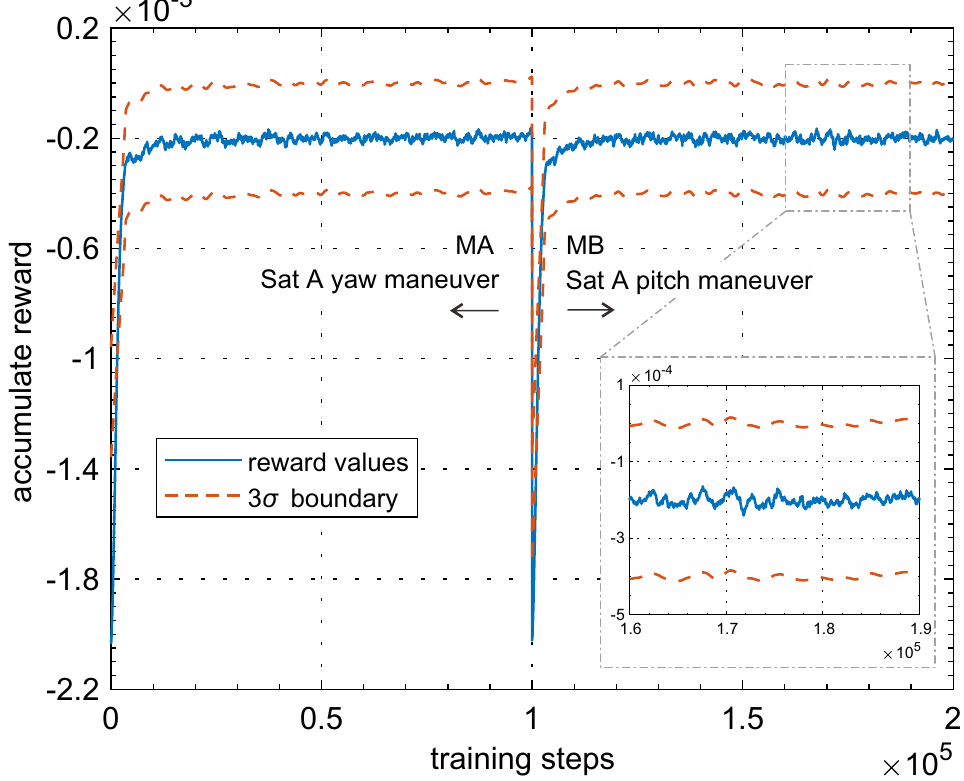
Figure 9. Learning data for software APC calibration